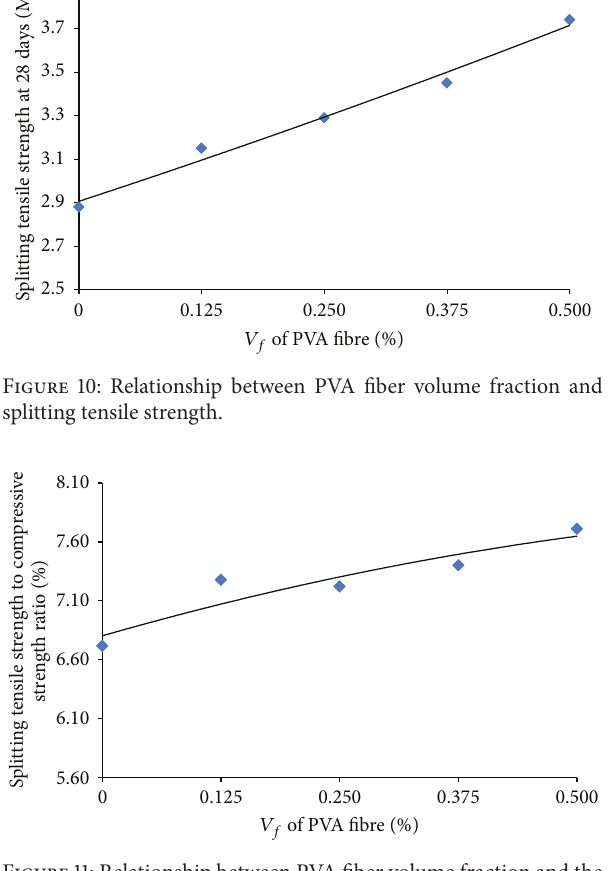
Figure 11: Relationship between PVA fiber volume fraction and the splitting tensile strength to compressive strength ratio.